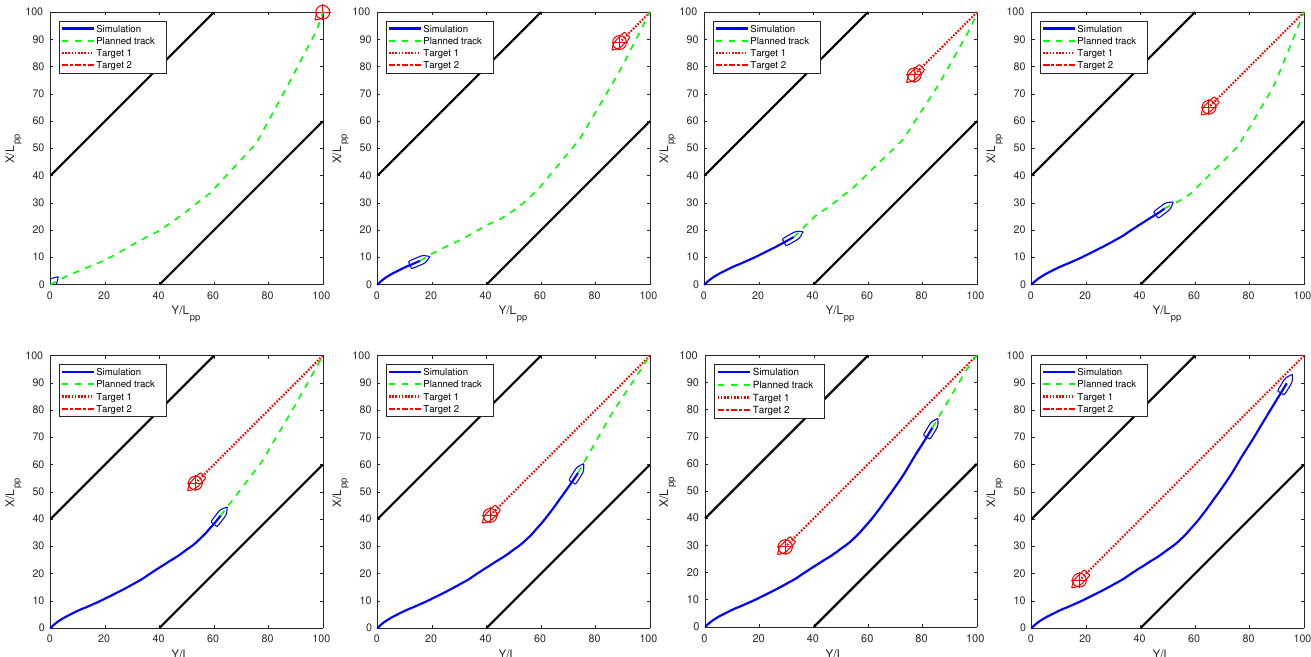
Figure 17. Scenario 3: simulation of a COLREG-compliant manoeuvre.